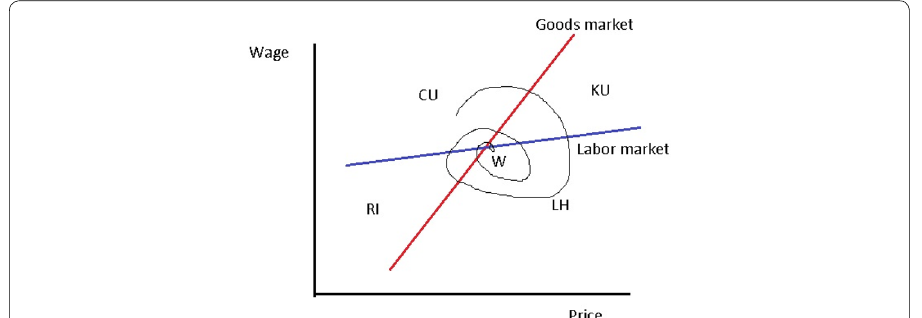
Fig. 5 Prices and wages in the different disequilibrium regimes (CU, KU, RI, LH). Stylized example, red line : goods market equilibrium, blue line : labor market equilibrium. Adopted from Malinvaud (1982) and Cudding- ton et al.